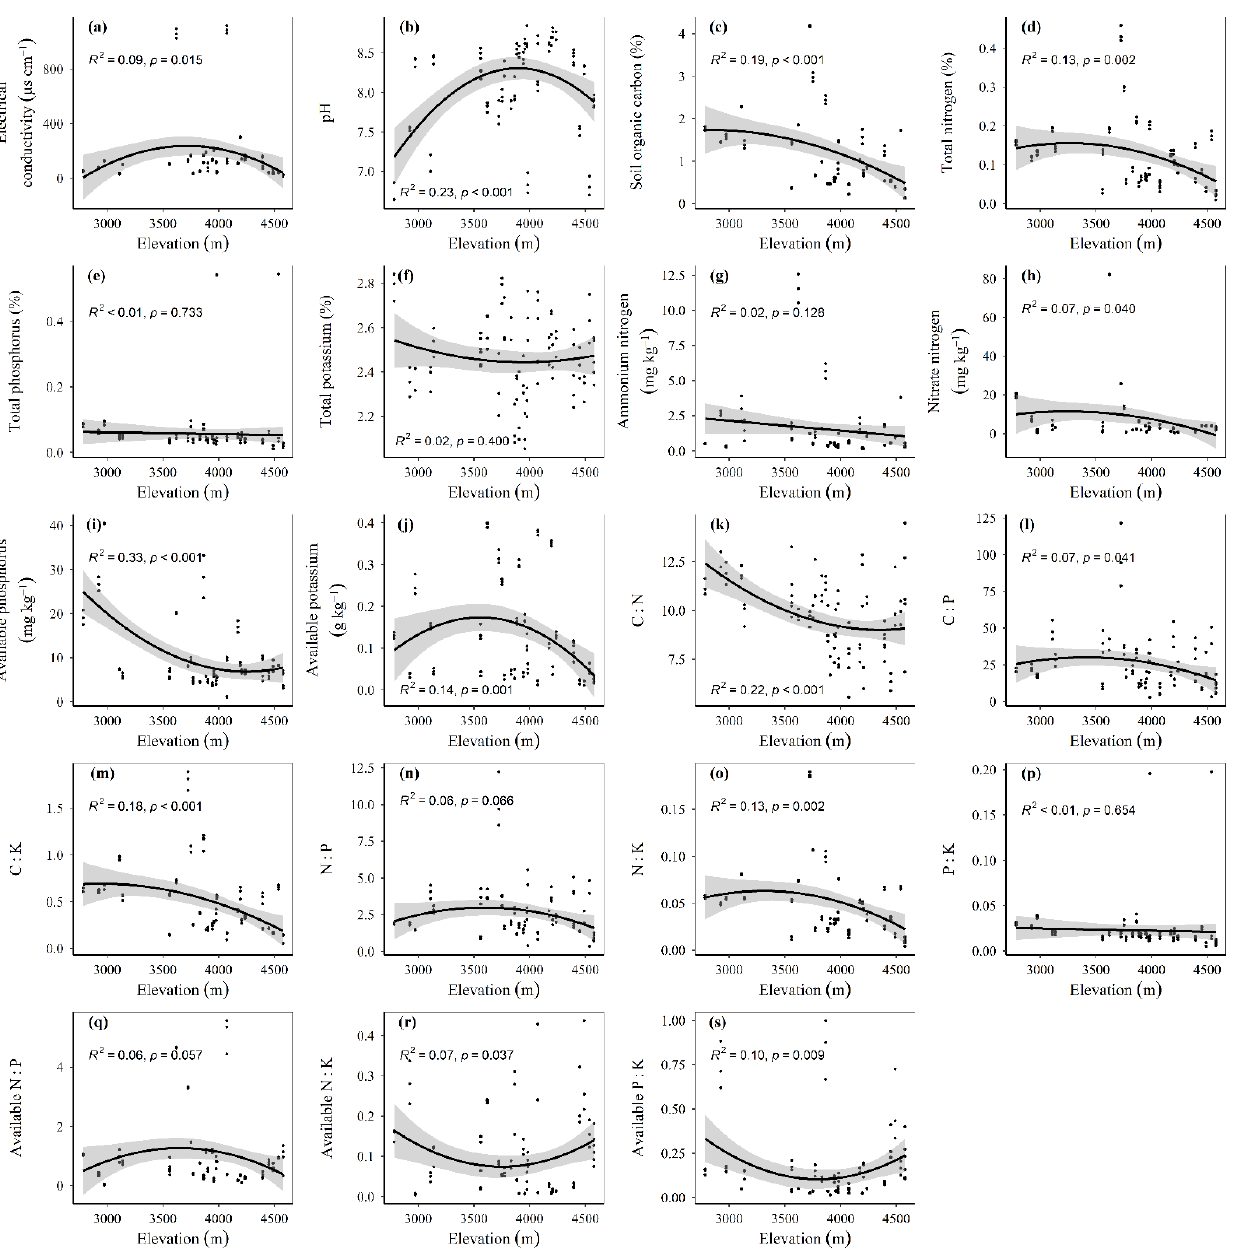
Figure A4. Relationships of elevation with soil ( a ) electrical conductivity, ( b ) pH, ( c ) soil organic carbon (SOC), ( d ) total nitrogen (TN), ( e ) total phosphorus (TP), ( f ) total potassium (TK), ( g ) ammonium nitrogen (NH 4+ -N), ( h ) nitrate nitrogen (NO 3 − -N), ( i ) available phosphorus (AP), ( j ) available potassium (AK), ( k ) ratio of SOC to TN (C:N), ( l ) ratio of SOC to TP (C:P), ( m ) ratio of SOC to TK (C:K), ( n ) ratio of TN to TP (N:P), ( o ) ratio of TN to TK (N:K), ( p ) ratio of TP to TK (P:K), ( q ) ratio of available nitrogen to AP (available N:P), ( r ) ratio of available nitrogen to AK (available N:K) and ( s ) ratio of AP to AK (available P:K) at a depth of 0–10 cm.